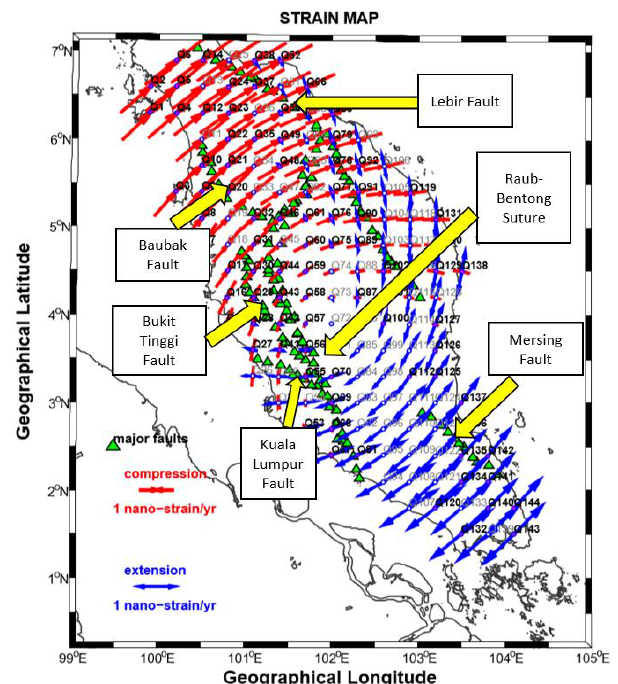
Figure 12. Strain rate map over Peninsular Malaysia in 2004.